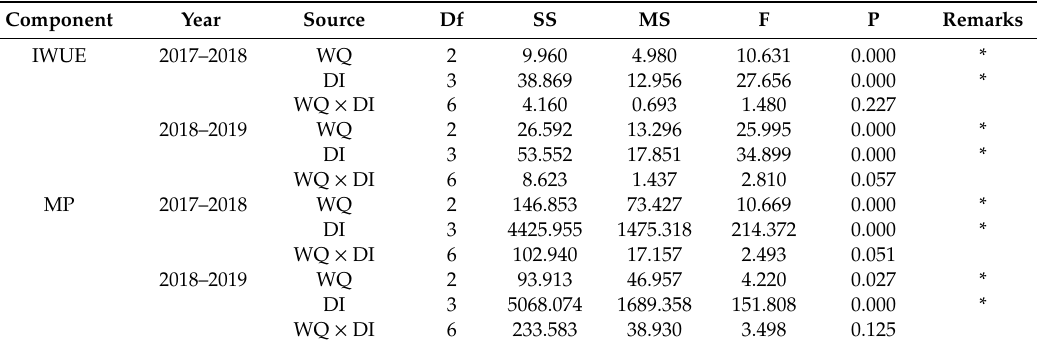
Table 7. Output of the two-way ANOVA for IWUE and MP under three water qualities (WQ), four irrigation scenarios (DI), and their interactions (WQ ×